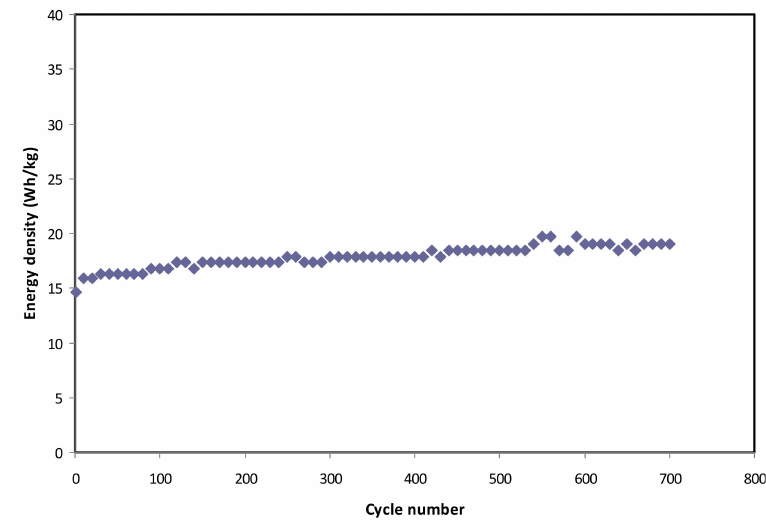
Figure 12. Energy density, E , of the fabricated EDLC for 700 cycles.